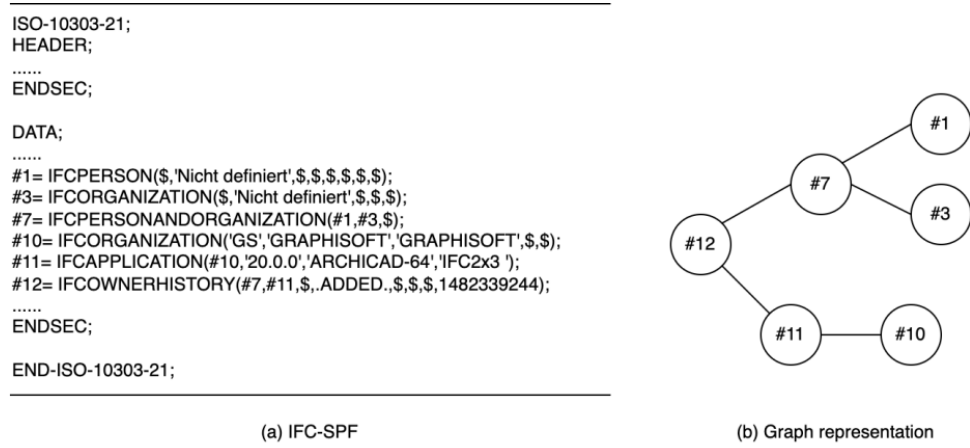
Figure 5. An example for part of IFC-SPF and its graph representation.